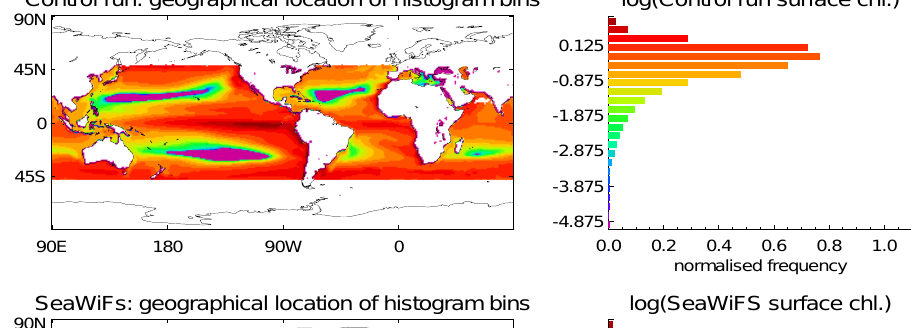
and HadCM3LC (blue) for Mauna Loa (left) and Barrow